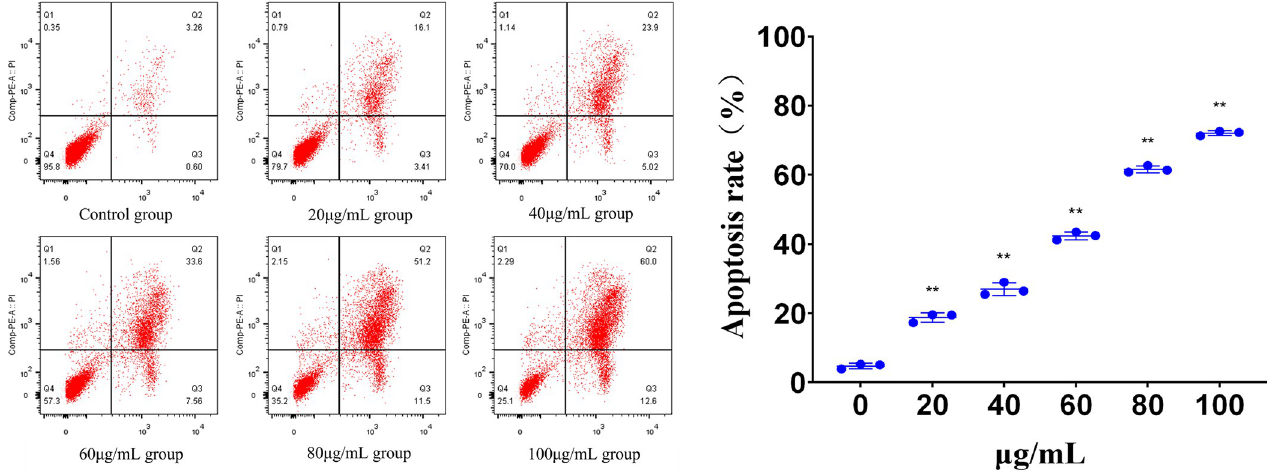
Fig 4. Effect of lingonberry extract on the apoptosis rate of HepG2 cells. ( a ) Effect of extract concentration on apoptosis. ( b ) Analysis of cell apoptosis rates in lingonberry treatment and control groups ( �� p < 0.01 compared to the control group).